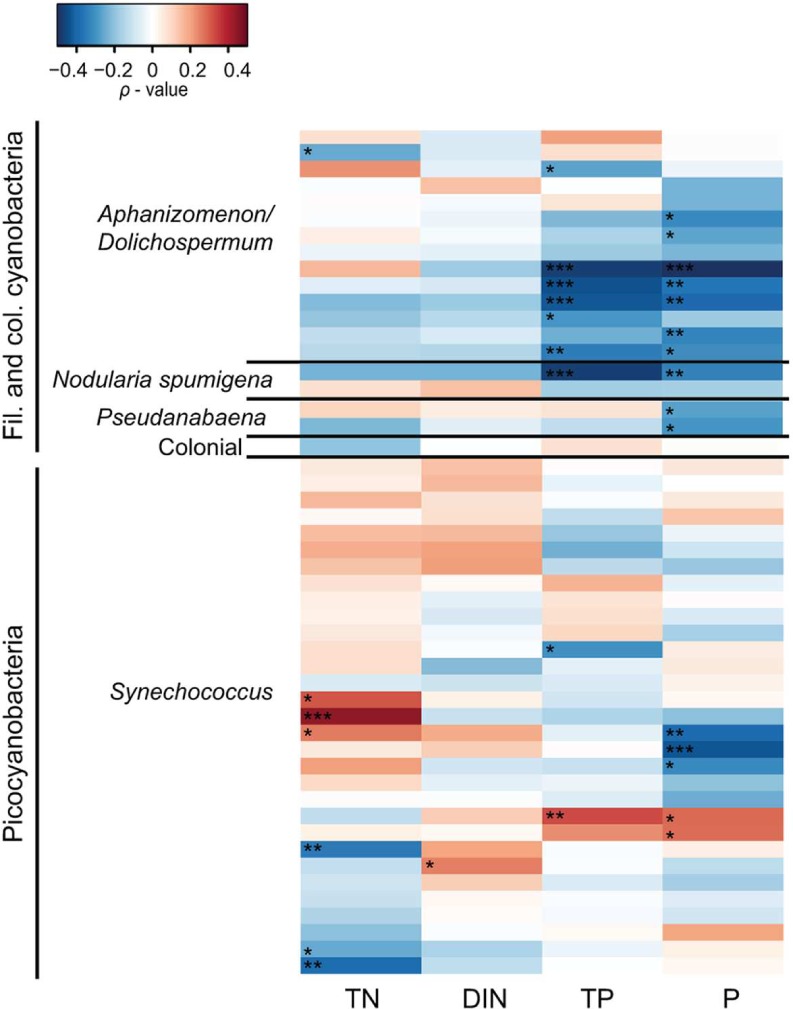
Heatmap representing Spearman correlation coefficients between the 50 most abundant cyanobacterial OTUs in 2011 and nutrients. Total nitrogen (TN), dissolved inorganic nitrogen (DIN; nitrogen and ammonium), total phosphorus (TP), phosphate (P) were used for the relationships. Only 2011 is shown because nutrient data was lacking for 2010. Statistical significance is ∗∗∗p < 0.001, ∗∗p < , ∗p < 0.05.